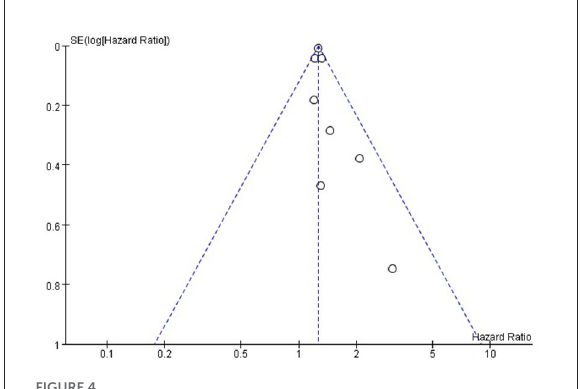
FIGURE4 Funnel plot for the publication bias underlying the metaanalysis of the associtation between TyG index and